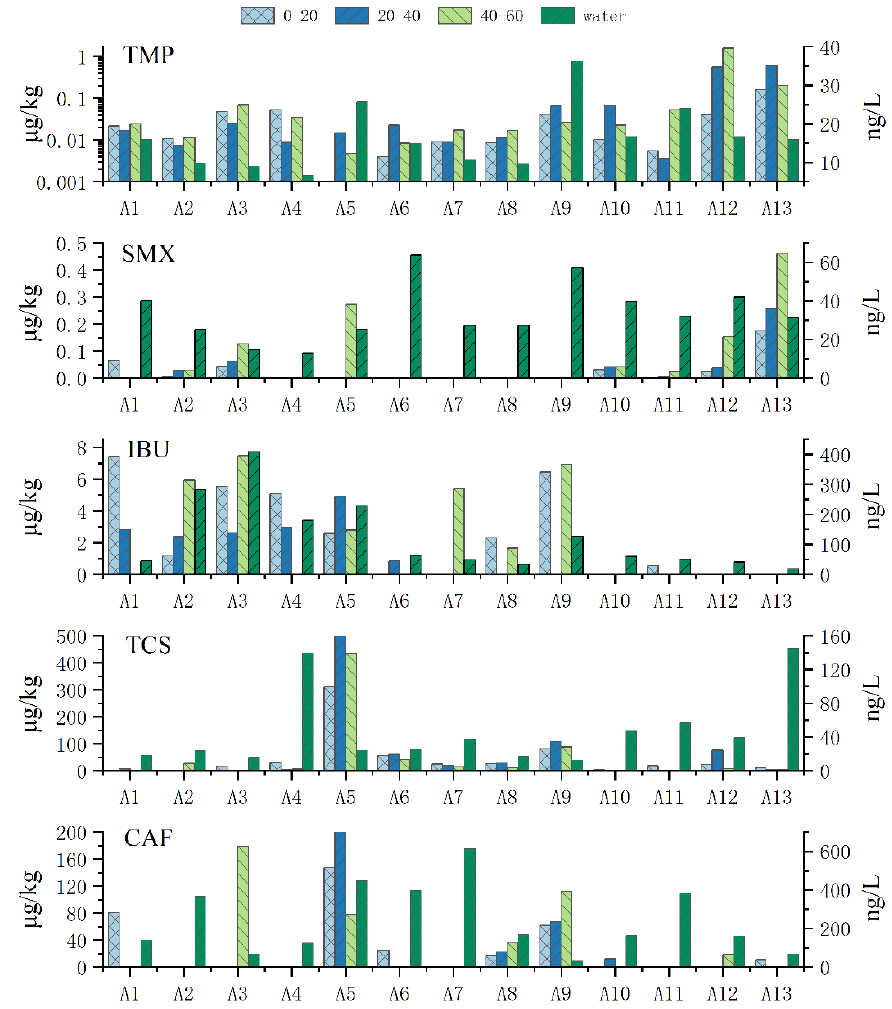
Figure 2. Spatial distribution of PPCP concentration in sediments of the North Canal.